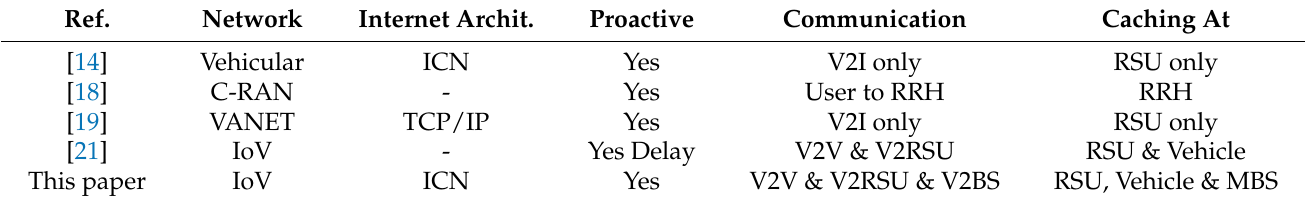
Table 1. Related